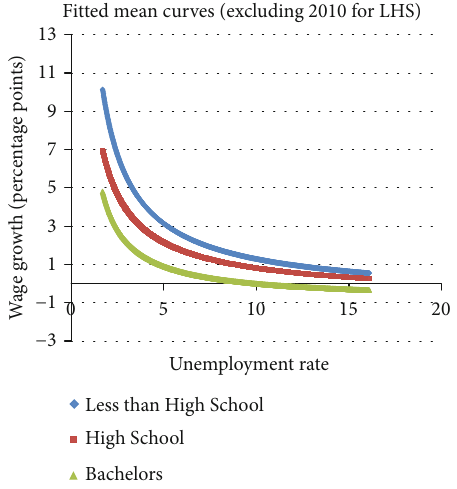
Figure 9: Fitted mean curves (excluding 2010 for LHS).